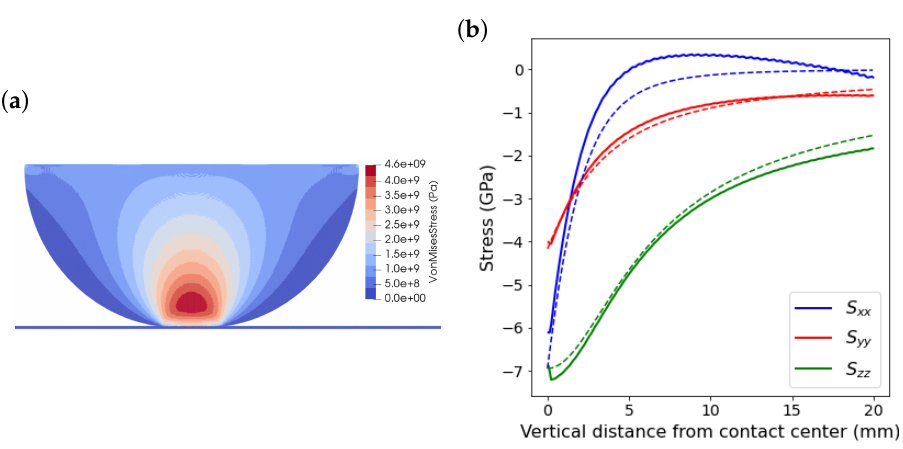
Figure 6. Numerical results for ( a ) von Mises stress field and ( b ) comparison between the calculated stress fields along the axis of symmetry and analytical solutions for the applied load of 50MN/m with particle spacing of 0.0625mm, where solid lines are the numerical results and dashed lines are the analytical